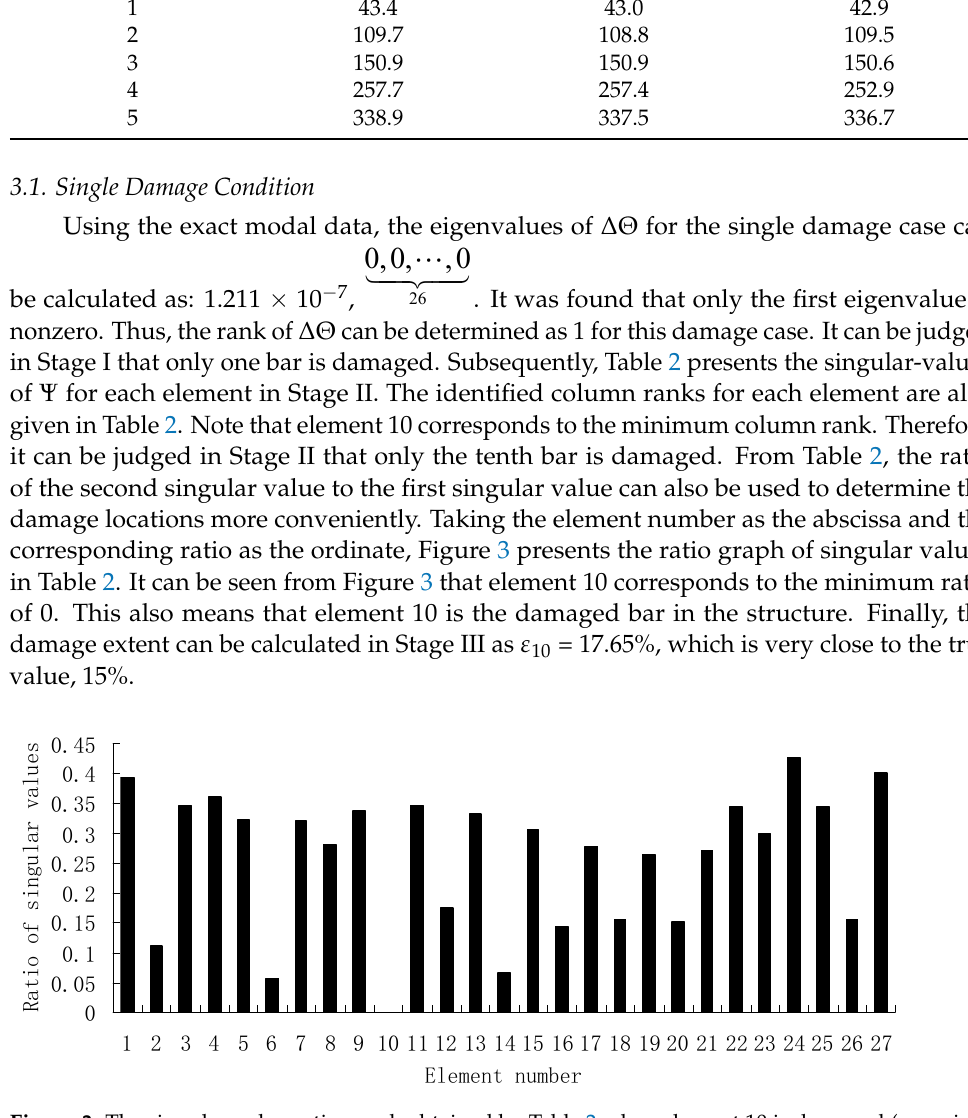
Figure 3. The singular-value ratio graph obtained by Table 2 when element 10 is damaged (no noise).